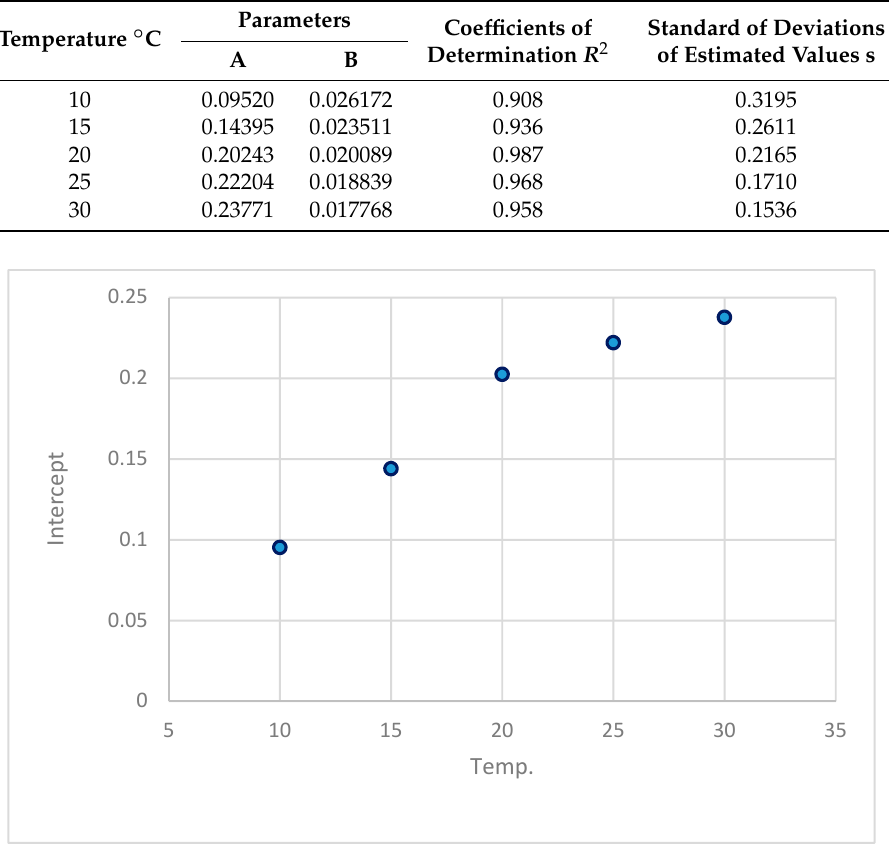
Figure 3. Effect of temperature on parameter A (intercept) of the linear equation.